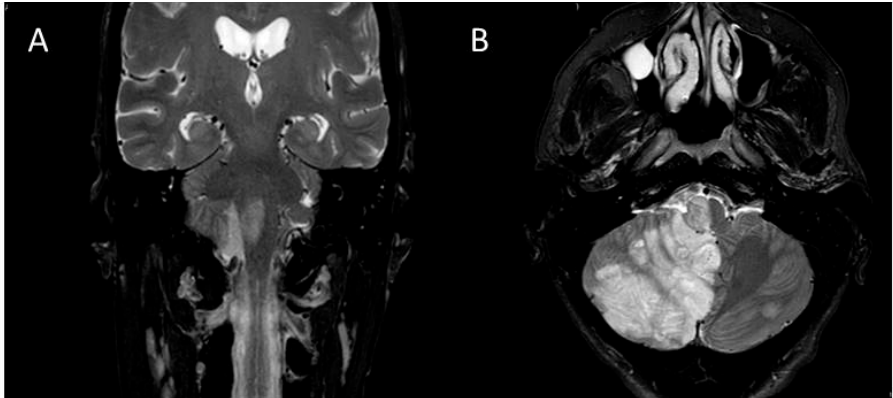
Figure 1. Coronal ( A ) and ( B ) transversal T2-weighted magnetic resonance imaging (MRI) which depicts ischemic stroke in the right cerebellar hemisphere, the upper medulla oblongata and the pontomedullary junction.